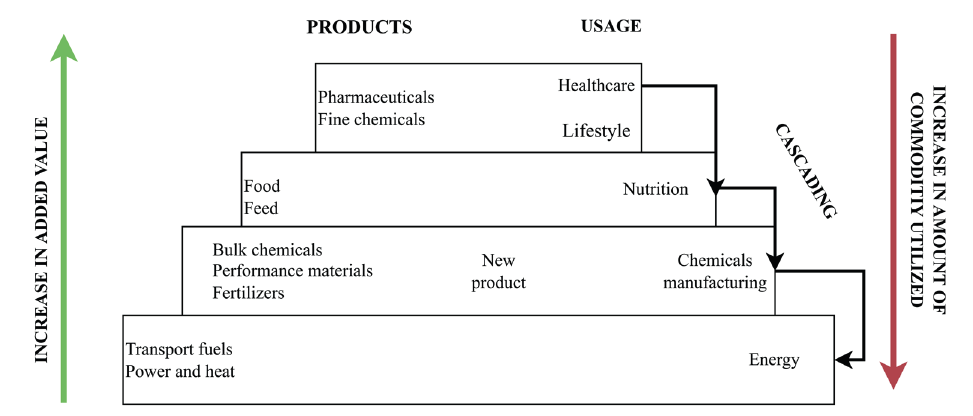
Fig. 1. Bioeconomy pyramid